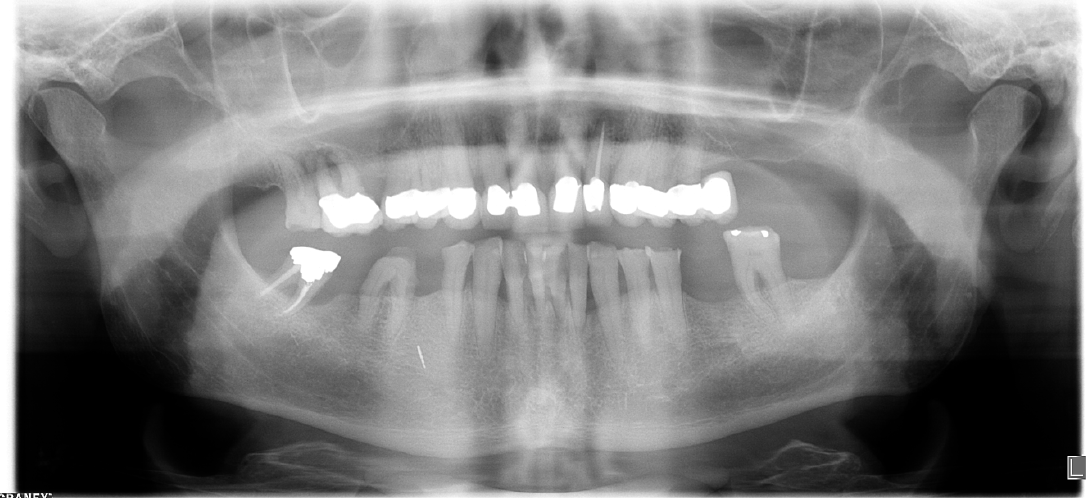
Figure 1. Orthopantomogram taken in October 2019.